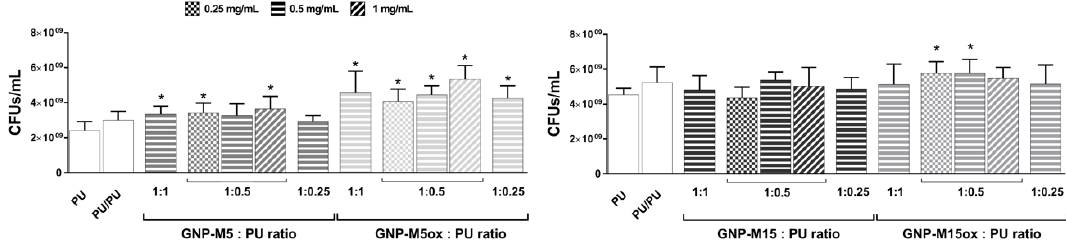
Figure 9. Antibacterial activity of PU/GNP coatings with different GNP concentration and GNP:PU ratio towards planktonic S. epidermidis after 24 h incubation determined by viable cell count. *, o, ∆ and # statistically significantly different from control PU film (PU), from PU coating on PU (PU/PU), from both and differences between the correspondent non ‐ oxidized samples, respectively (one ‐ way ANOVA (B); p ≤ 0.05).